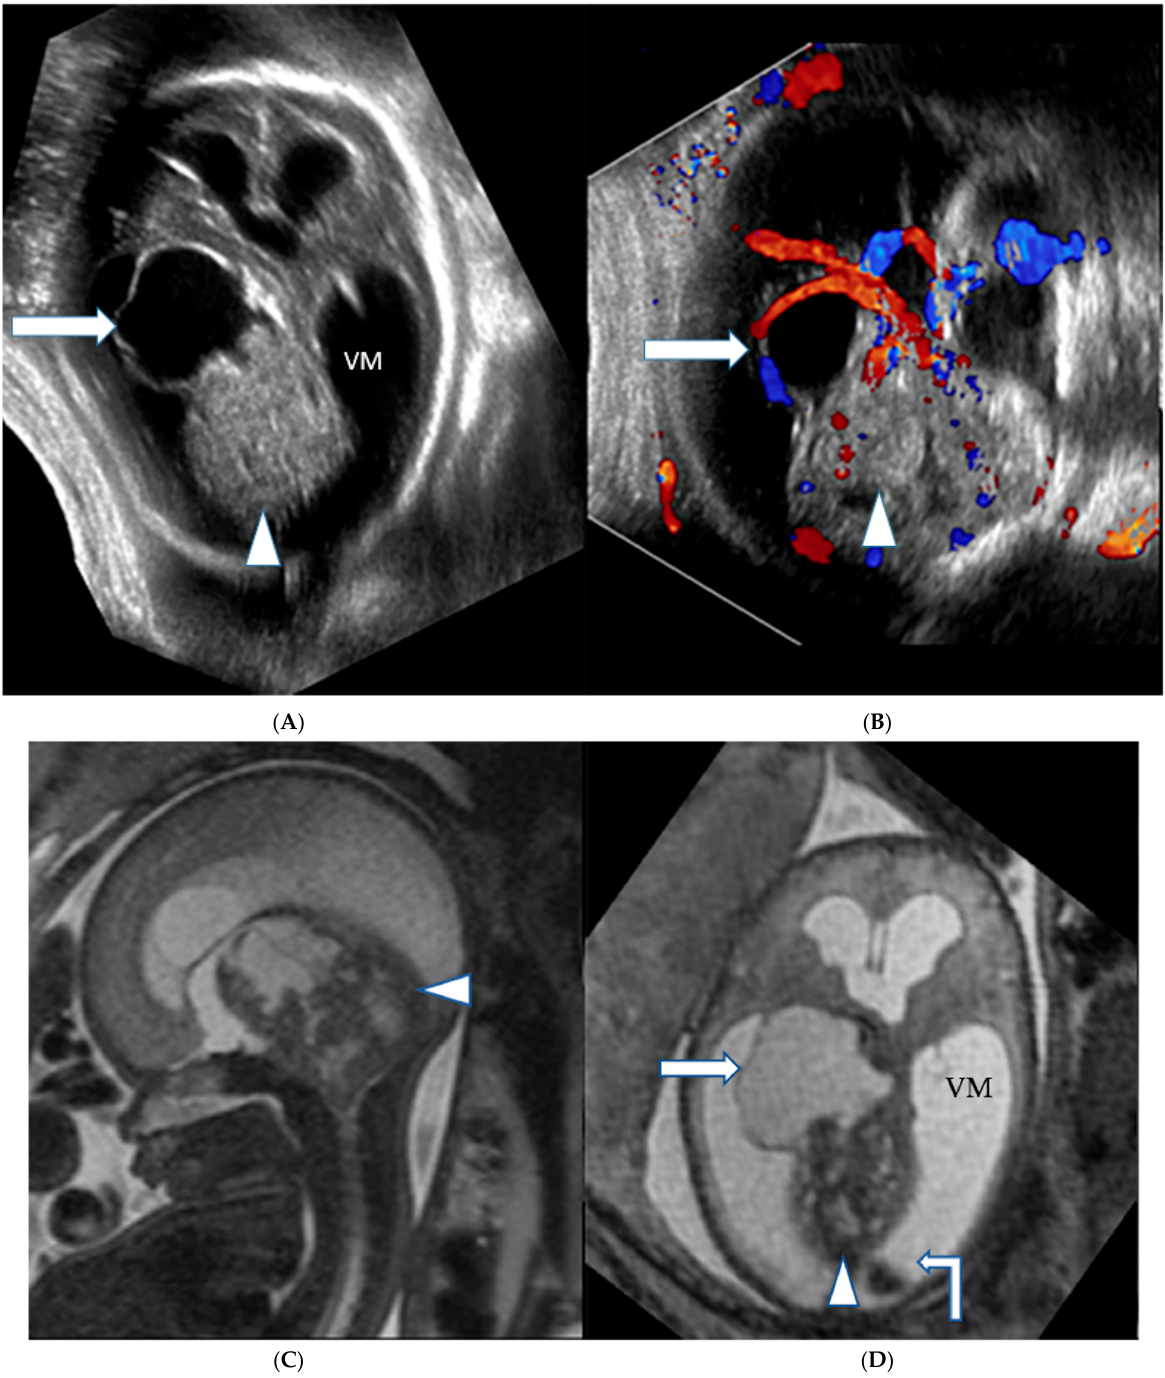
Figure 3. ( A , B ): Gray scale and color-coded Doppler sonography US shows a large heterogeneous hyperechogenic solid (arrowhead), partially hypoechogenic cystic (arrow) mass lesion filling out the posterior fossa with compression of the brainstem, cerebellum and vermis. A cystic component herniates through the tentorial incisura into the supratentorial left lateral ventricle. The lesion appears well perfused on Doppler ultrasound. ( C , D ): Matching T2-weighted fetal MRI confirms the large posterior fossa mass lesion (arrowhead) with resultant high grade supratentorial ventriculomegaly (VM). A large compared to the cerebrospinal fluid slightly T2-hypointense cyst extends into the left lateral ventricle indicating a higher protein content, possibly hemorrhage within the cyst (arrow). A blood-cerebro-spinal fluid level is noted in the right lateral ventricle (angeled